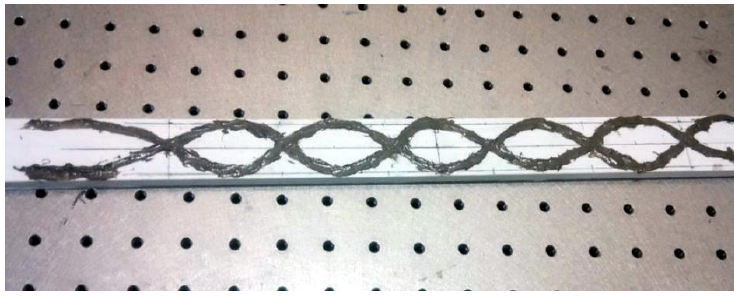
Figure 8. Dual-sinusoidal FOSs’ placement embedded on a glass composite Figure 8 . Dual-sinusoidal FOSs ’ placement embedded on a glass composite specimen.